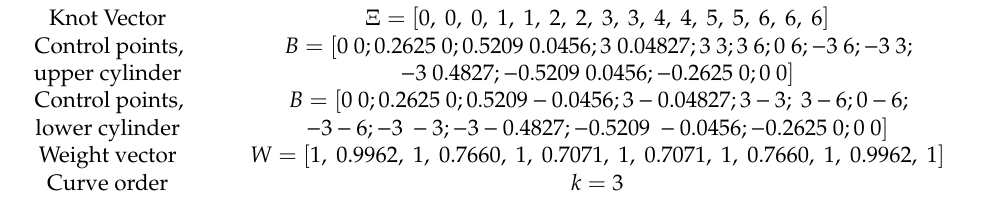
Table 6. Data to create NURBS curve from the plane strain problem. Table 5. Data to analyze the contact problem with the proposed method.